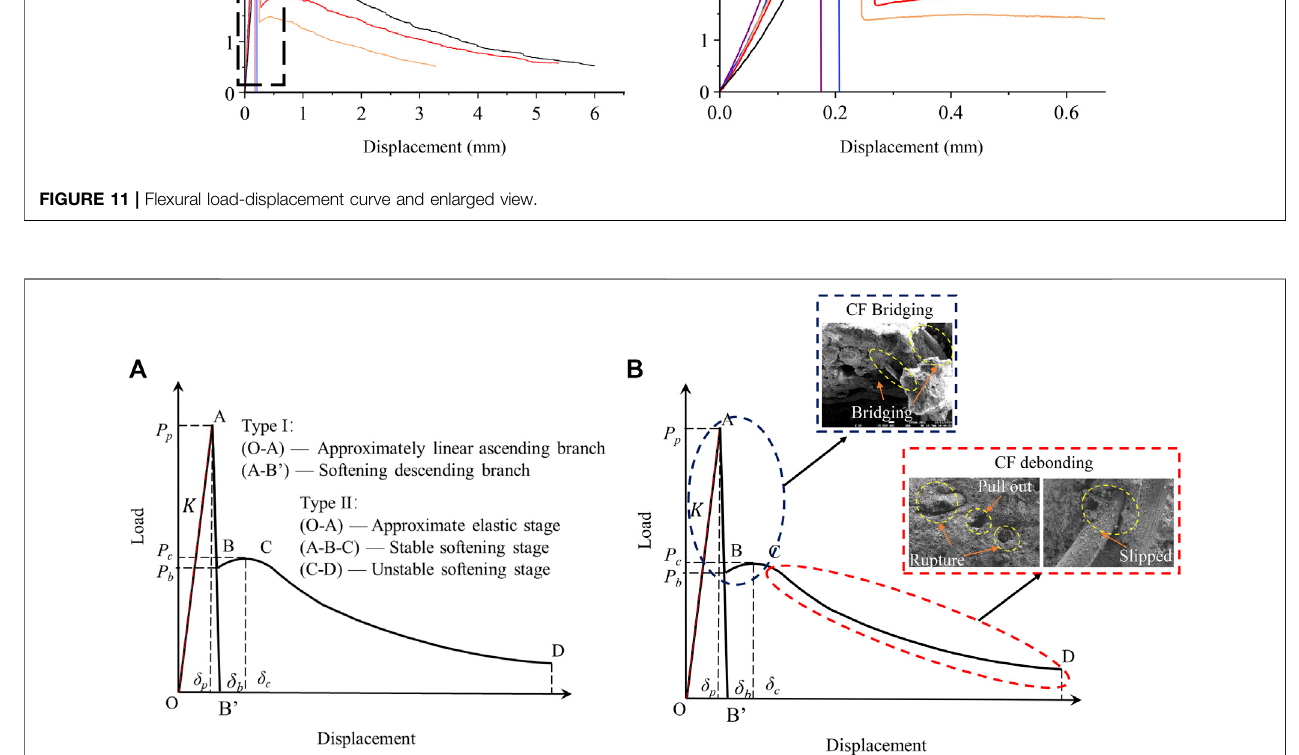
FIGURE 12 | Load-displacement curve con fi guration and sketch of failure mechanism (A) curve con fi guration; (B) sketch of failure mechanism.